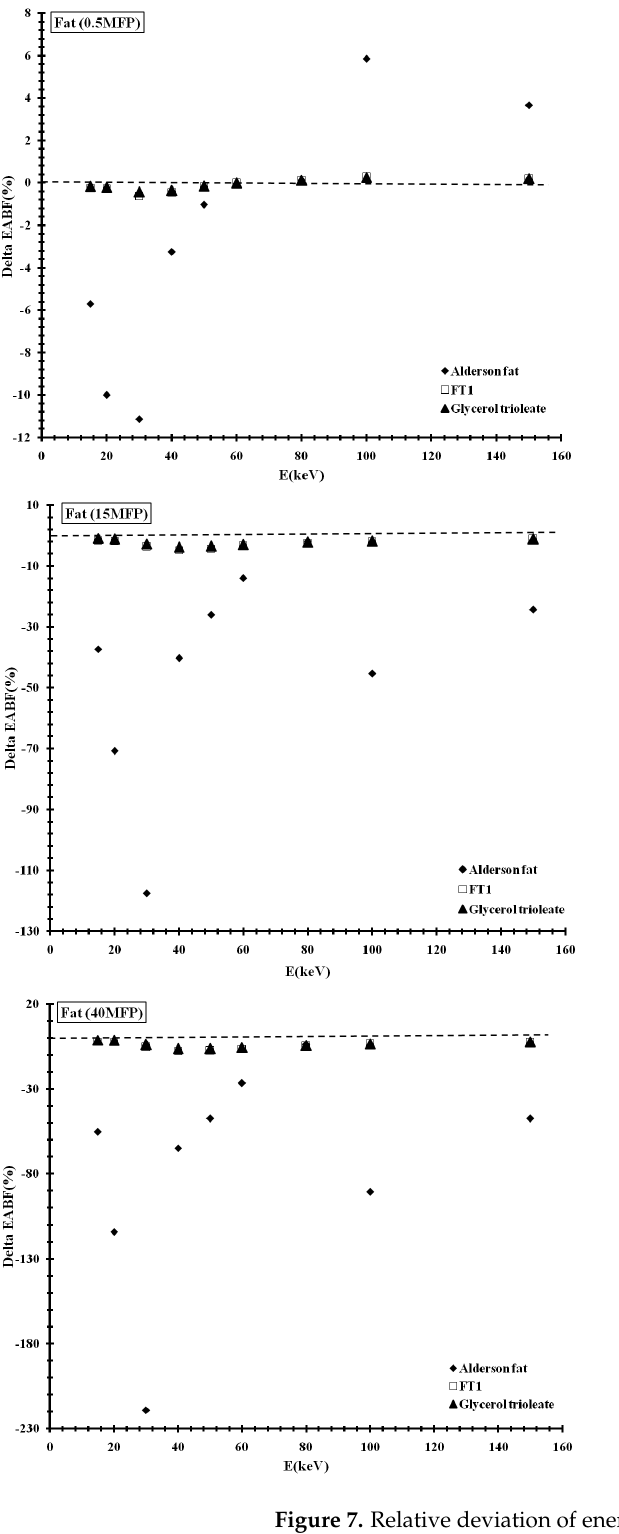
Figure 7. Relative deviation of energy absorption buildup factor of substitute materials to fat tissue as a function of: ( left side) photon energy for fixed depths of 0.5, 15 and 40 mfp and ( right side) depth for fixed photon energy of 30, 80 and 150